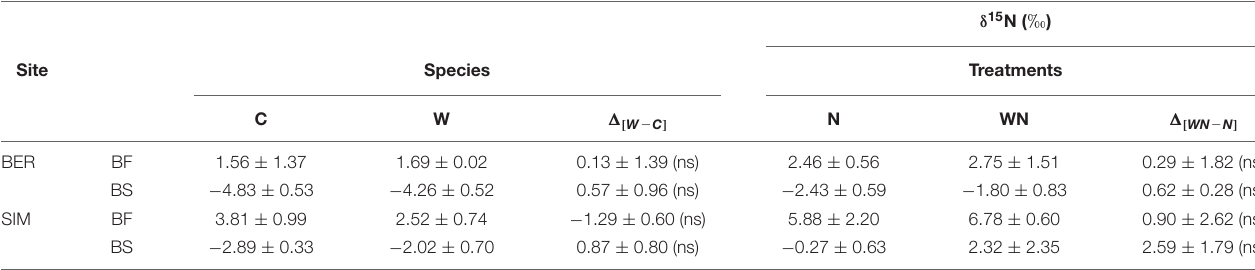
The differences in foliar δ 15 N between the warmed (W) and the control (C) plots ( (cid:49) [ W − C ] ) and between the warmed and fertilized (WN) and fertilized-only (N) plots ( (cid:49) [ WN − N ] ) are displayed to show the effect of soil warming on foliar δ 15 N in the unfertilized and fertilized plots, respectively. ns, not significant (P >